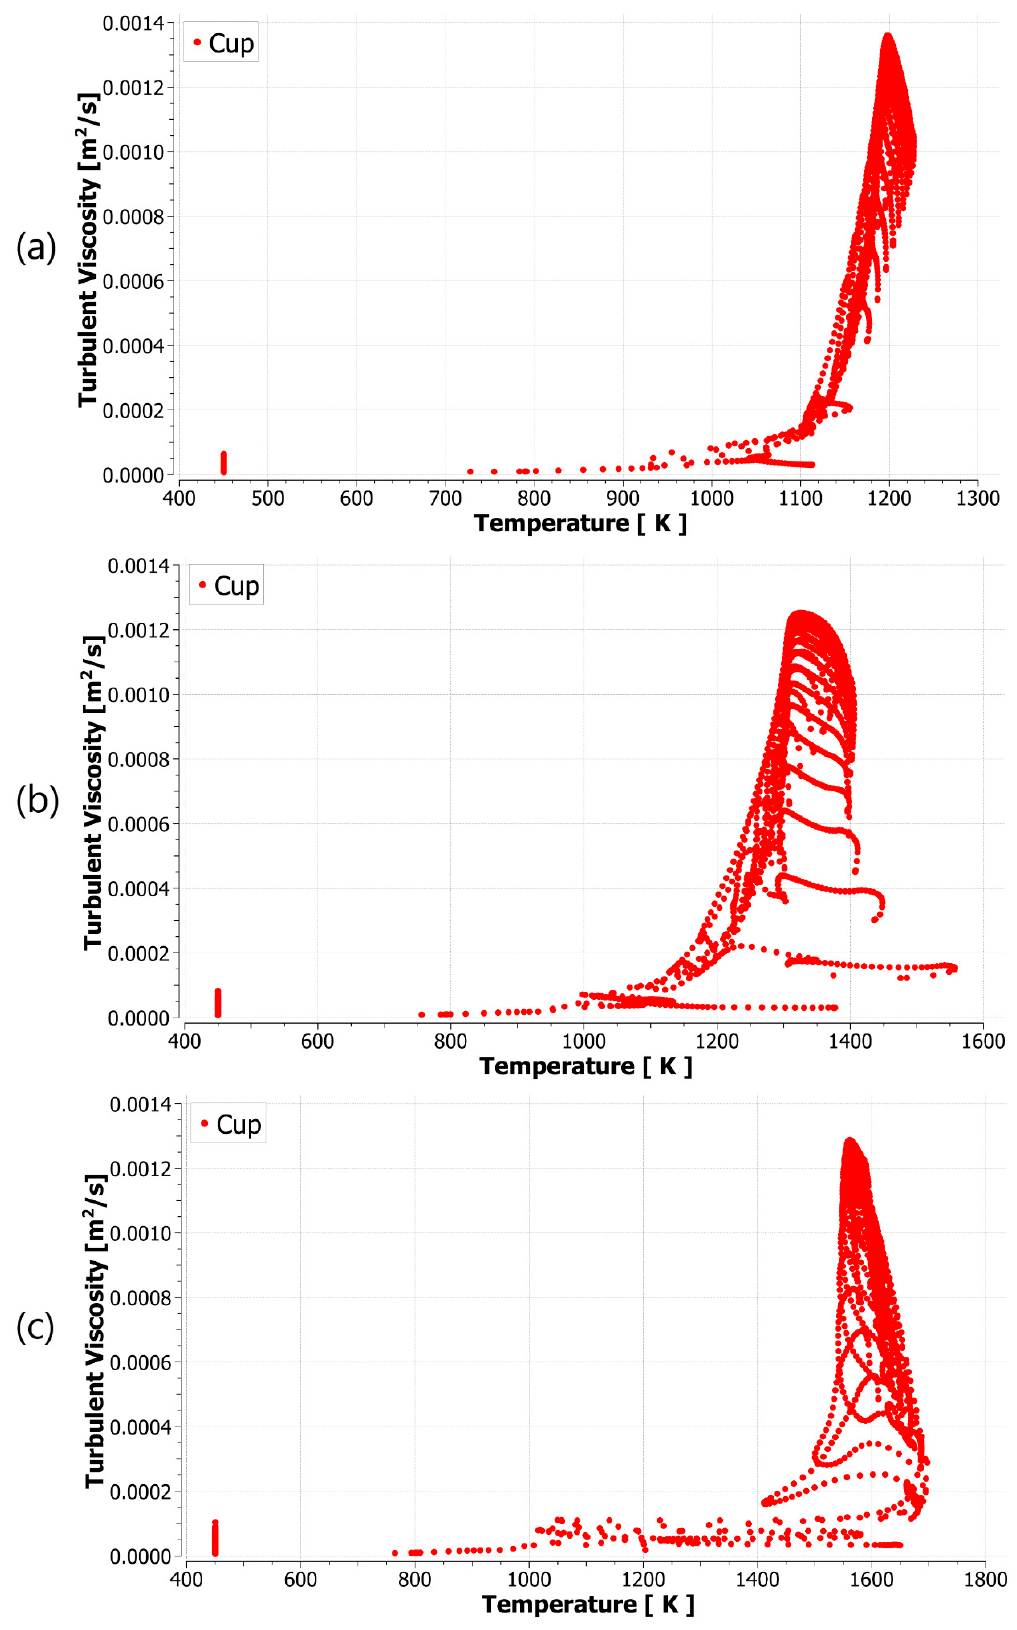
Figure 5. Scatter plots of the turbulent diffusivity as a function of gas temperature at different crank angles: ( a ) TDC; ( b ) 5 CAD ATDC; ( c ) 10 CAD ATDC.